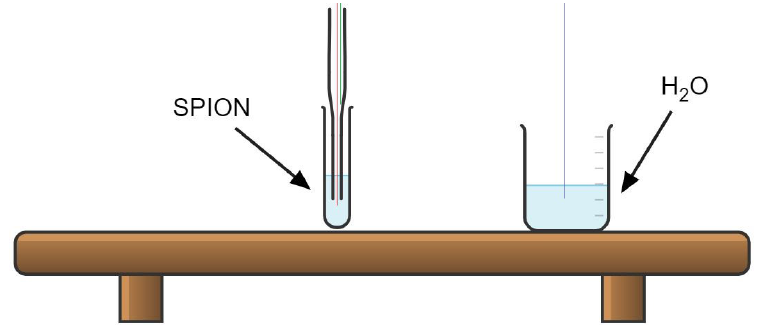
Figure 3. Fiber optic temperatue sensor placement.